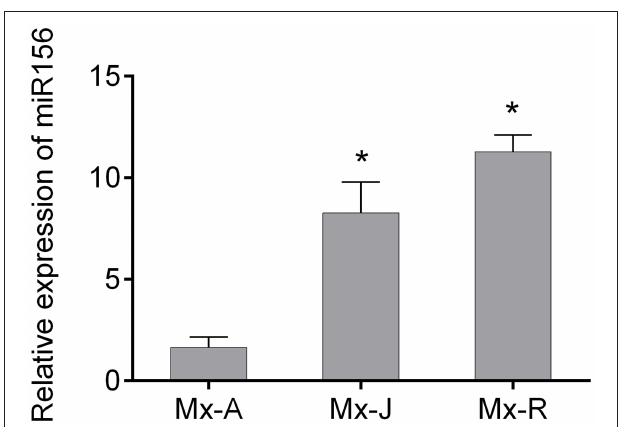
FIGURE 2 | Expression level of miR156 in adult phase (Mx-A), juvenile phase (Mx-J), and rejuvenated (Mx-R) leafy cuttings of Malus xiaojinensis . MicroRNA was extracted from Mx-A, Mx-J, and Mx-R cuttings before IBA treatment. Relative expression was measured with quantitative real time PCR and normalized to that 5S rRNA . Asterisks indicate statistical significance (* P < 0.05) in comparison with Mx-A. Bars show SD from three biological